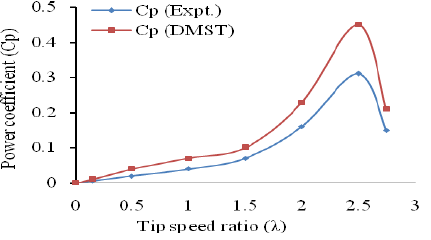
Figure 14. Cp versus λ at V ∞ = 4 m/s